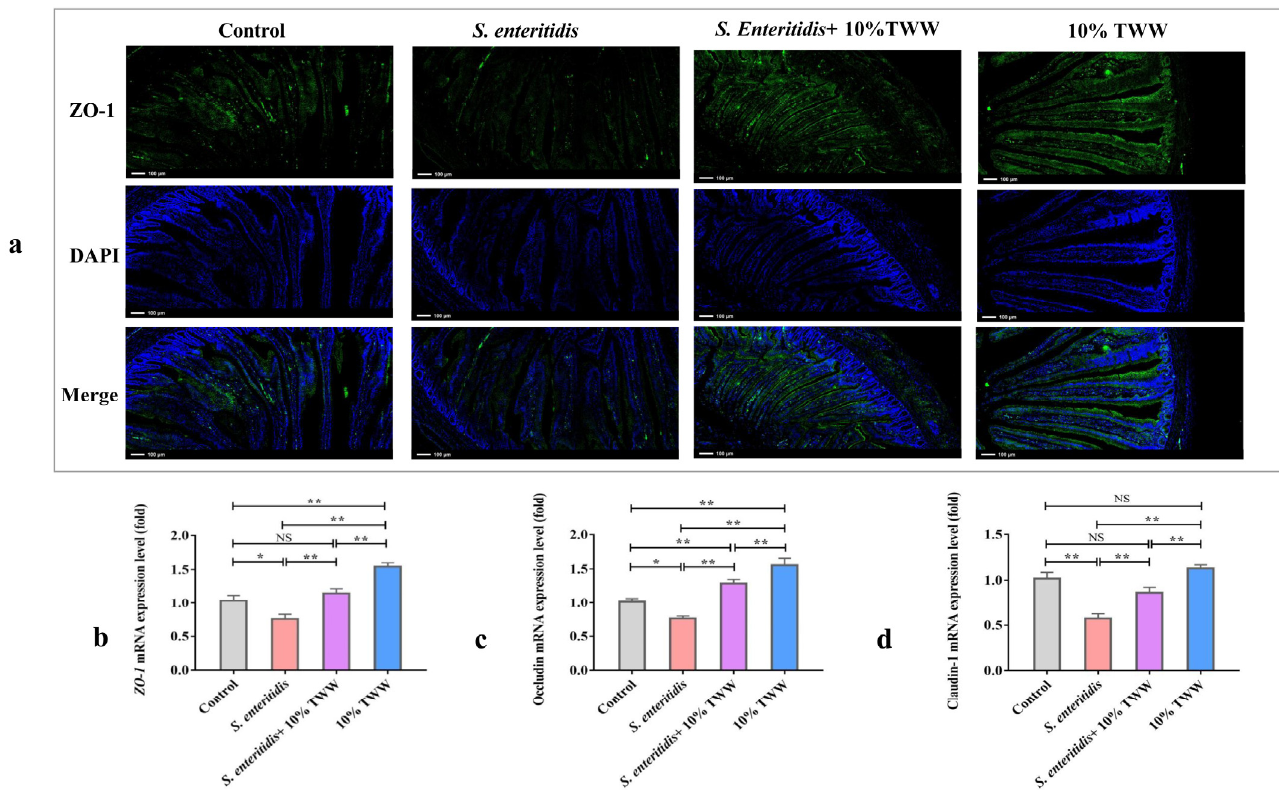
Figure 7. TWW enhances the tight junction protein expression level in the jejunum of S. enteritidis - infected chickens. ( a ) Sections of jejunum tissue were immunostained with anti-ZO-1 (red) and DAPI (blue) (100× magnification). ( b – d ) The mRNA levels of ZO-1 , Occludin , and Claudin-1 in the jejunum. Values presented as means ± SEM. * p < 0.05, ** p < 0.01, compared between the indicated groups. NS: no significance between the indicated groups.